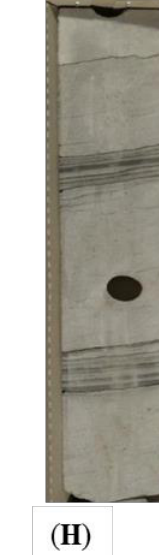
Figure 9. Medium-grained turbidite family: photographic examples. ( A ) Sandstone turbidite succession (thin-, medium- and thick-bedded) interbedded with fine-grained turbidites (mud-rich), Annot Basin, SE France. ( B ) Sandstone–mudstone turbidite succession, thin- and medium-bedded, Zumaia Formation, N Spain. Scale stick 1.5 m. ( C ) Sandstone–mudstone turbidite succession, thin-bedded, Aberystwyth Grit Formation, Wales. ( D ) Sandstone–mudstone turbidite succession, thin- and medium-bedded, Apennines, Italy. ( E ) Example from Aberystwyth Grit Formation, Wales, showing Bouma sequence A–E turbidite. ( F ) Example from Misaki Formation, Japan, showing Bouma sequence A–E turbidite. ( G ) Example from Mzia Field, offshore Tanzania, showing sandy turbidites interbedded with fine-grained mud–silt turbidites. Core width 10 cm, scale bar in inches. ( H ) Example from North Brae Field, UK North Sea, showing sandy turbidites interbedded with fine-grained mud–silt turbidites. Core width 10 cm.